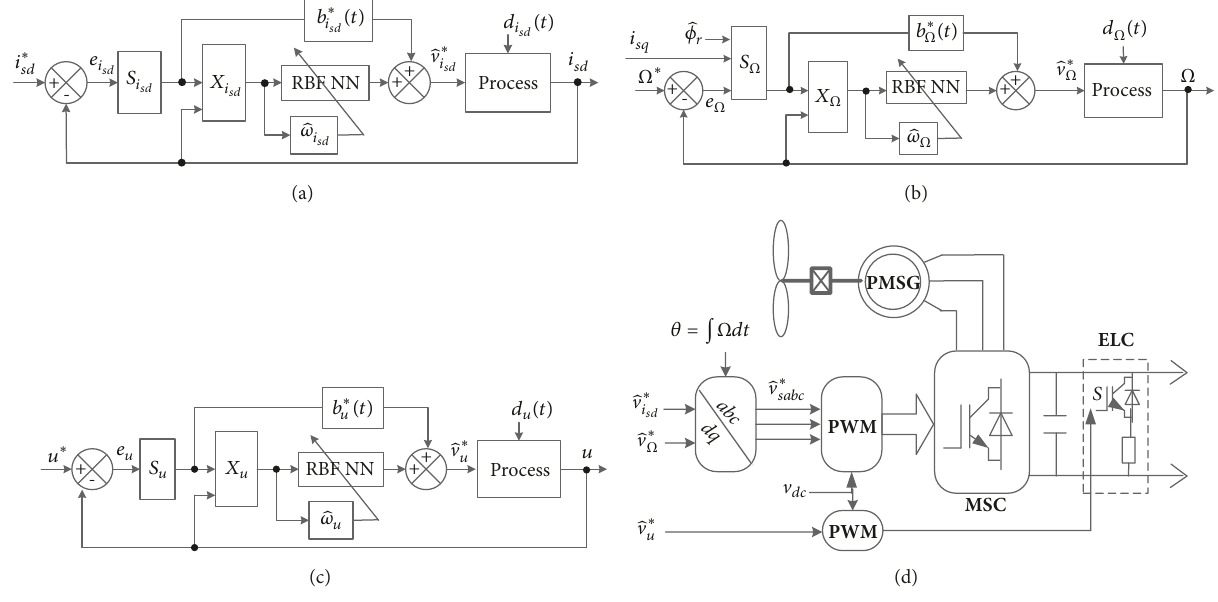
Figure 2: Block diagram of the proposed RBF neuro-sliding